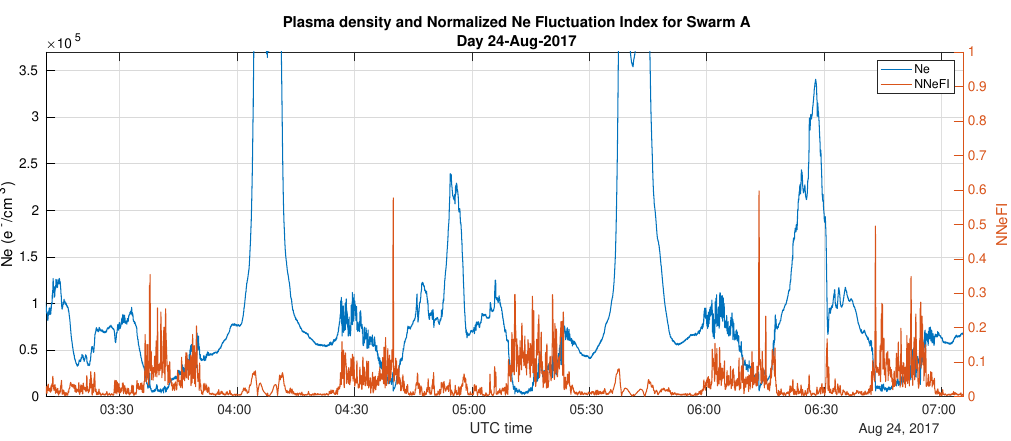
Figure 22. Plasma density (Ne) and Normalized Ne Fluctuation Index for Swarm A during some hours on day 24 August 2017. Note the values of NNeFI when there is fluctuations in the plasma density.